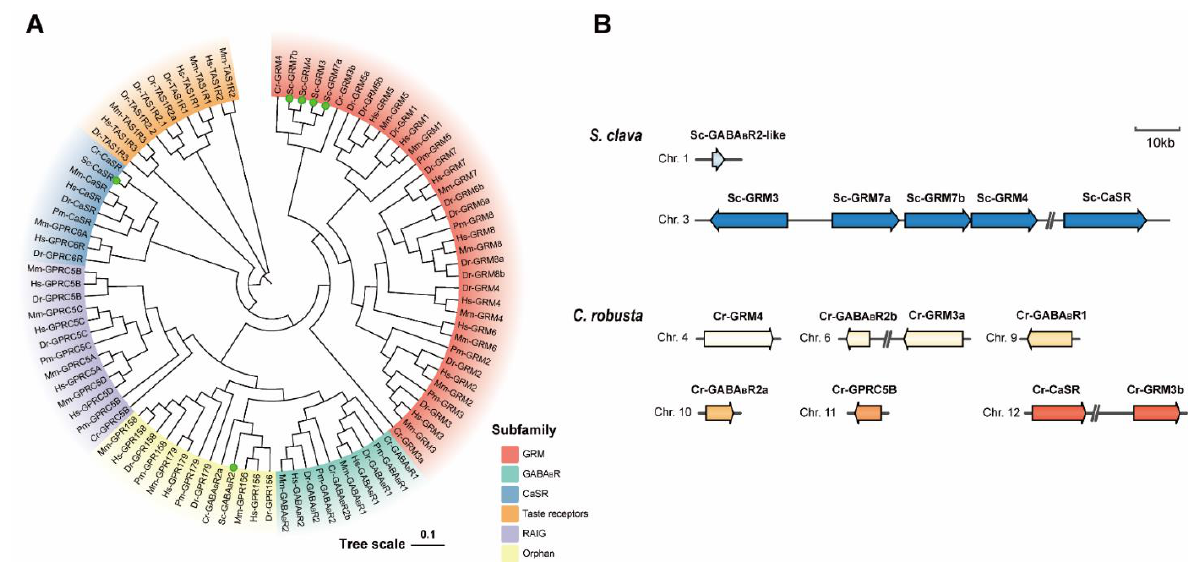
Figure 2. Phylogenetic tree and chromosomal locations of S. clava Class C GPCRs. ( A ) Phylogenetic tree of Class C GPCRs was constructed using the Neighbor-Joining method. Green dots indicate S. clava Class C GPCRs. Different subtypes of receptors are shaded in different colors. The species abbreviations: Hs, H. sapiens ; Mm, M. musculus ; Dr, D. rerio ; Pm, P. marinus ; Cr, C. robusta ; Sc, S. clava . The NCBI accession numbers for sequences used in the phylogenetic analysis can be found in Table S4. ( B ) Chromosomal locations of S. clava and C. robusta Class C GPCRs are shown in colored arrows. The direction of arrow indicates forward strand (right) and reverse strand (left). The scale bar represents a length of 10 Kb (the information for other species can be found in Table S3).